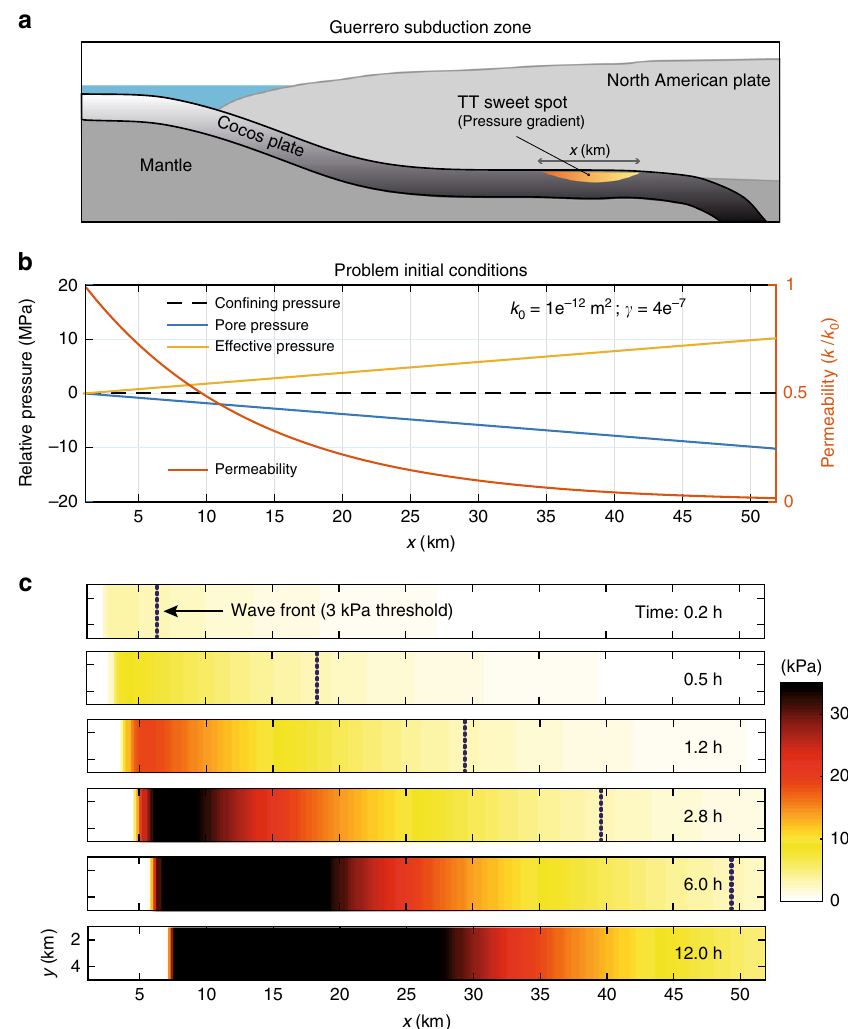
Fig. 2 Downdip pore-pressure wave solution under plausible conditions for the Guerrero subduction zone. a Cartoon showing the geometry of the oceanic Cocos plate under the continent. The gradient of gray colors illustrates the lithostatic pressure in the subducted slab, while color gradient illustrates local pore pressure changes in the sweet spot. b Initial conditions and parameter values for the simulation presented in Fig. 1a, b. c Resulting pore-pressure wave propagation in the 2D domain. The dashed black line depicts the wave front for a pressure threshold of 3